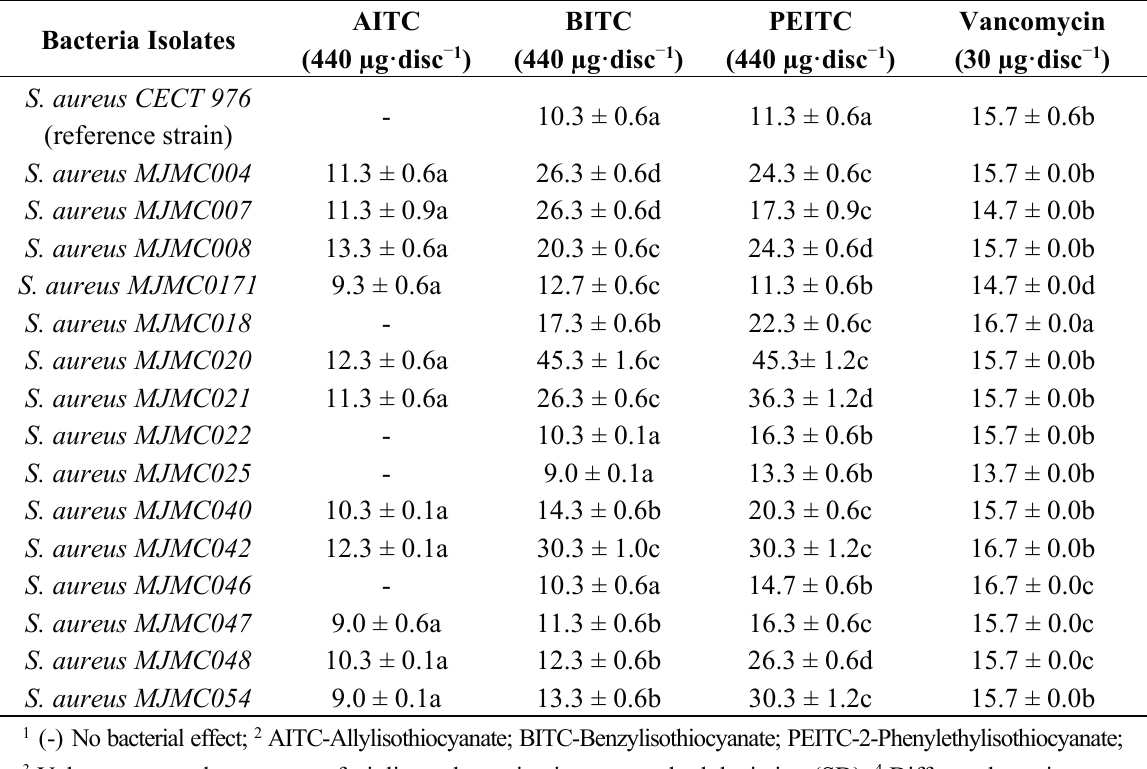
Table 1. Inhibitory diameter zone in mm for Isothiocyanates (ITCs)